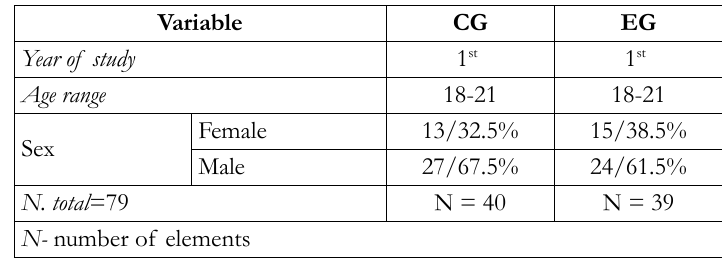
Table 2. Distribution and characteristics of the present student